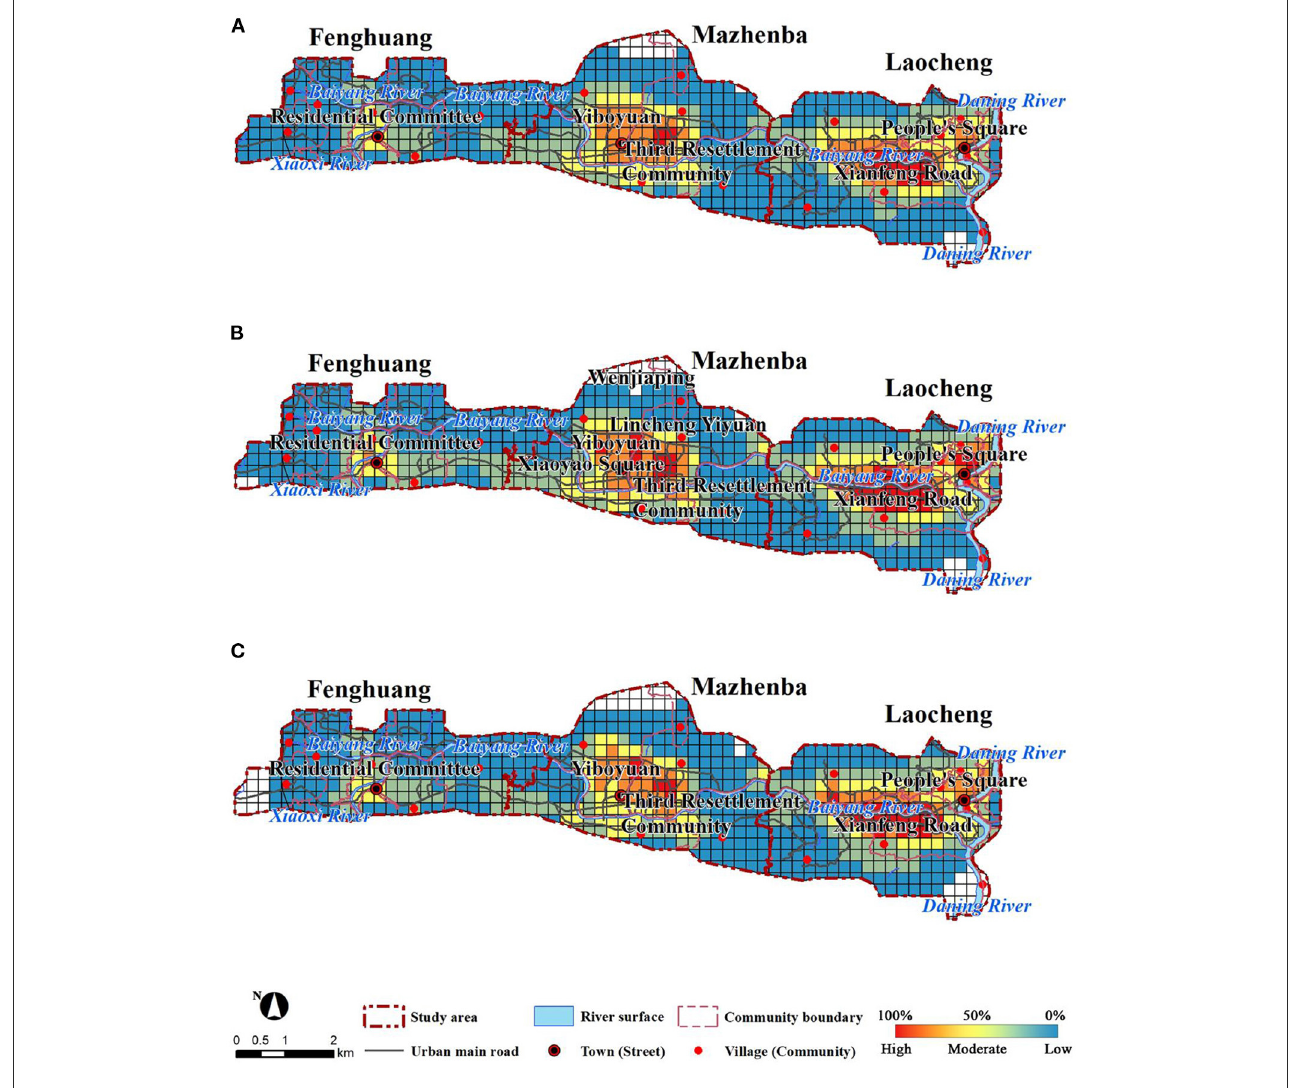
FIGURE4 Distributions of urban vitality: morning (A) , afternoon (B) , and evening (C) .